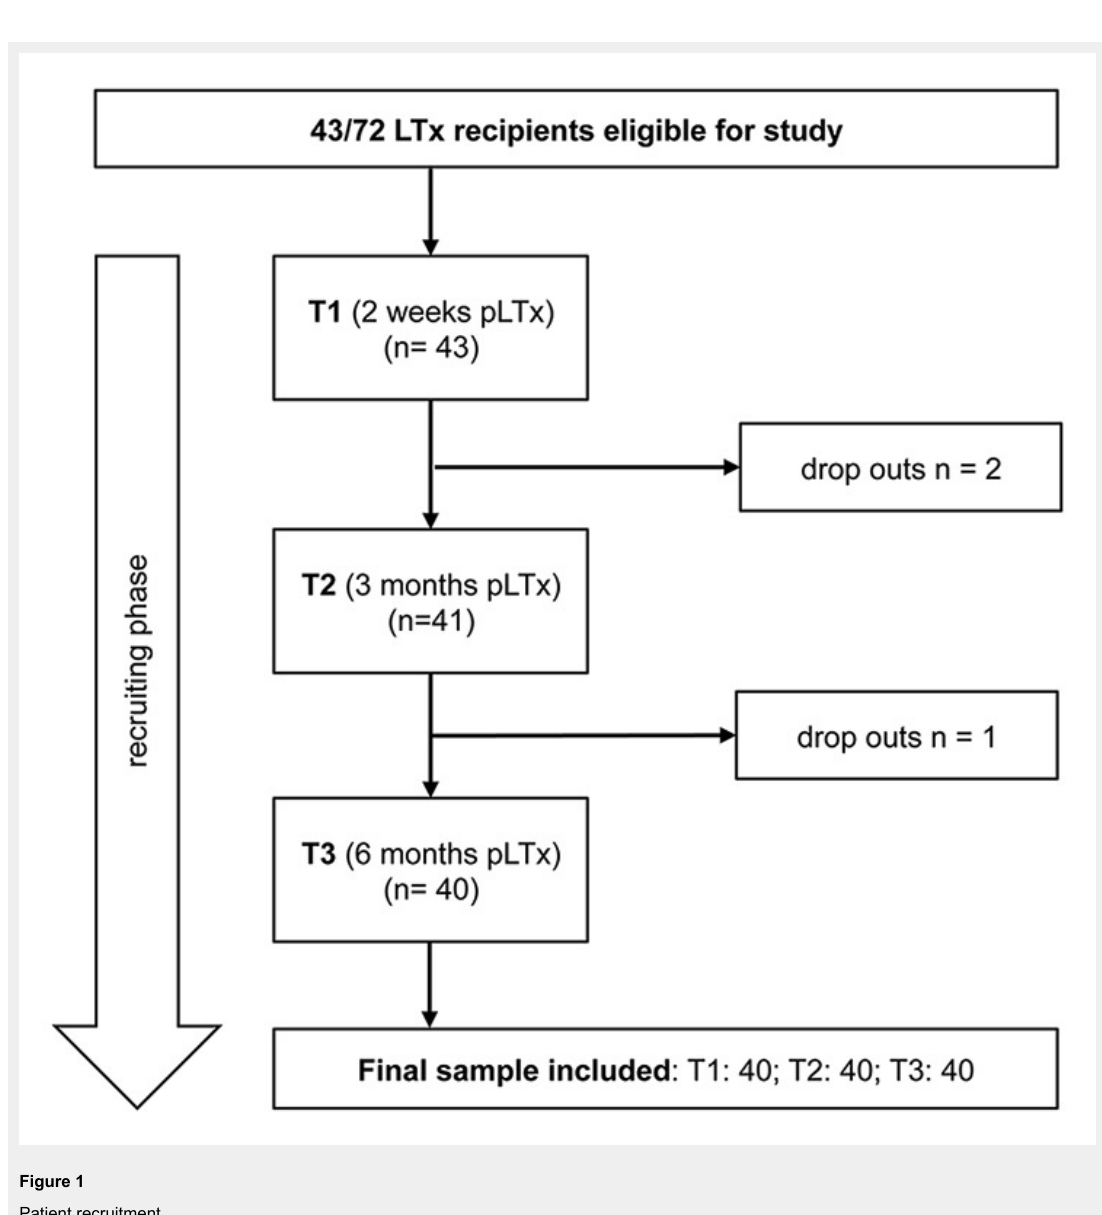
Patient recruitment. LTx = lung transplantation; pLTx = post lung transplantation; T1–T3 = three measurement